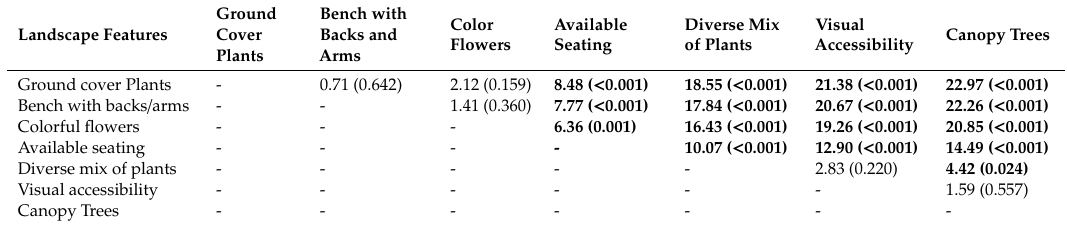
Table 3. Mean di ff erences and p -values for comparing preferences between Table 3. Mean differences and p -values for comparing preferences between features.